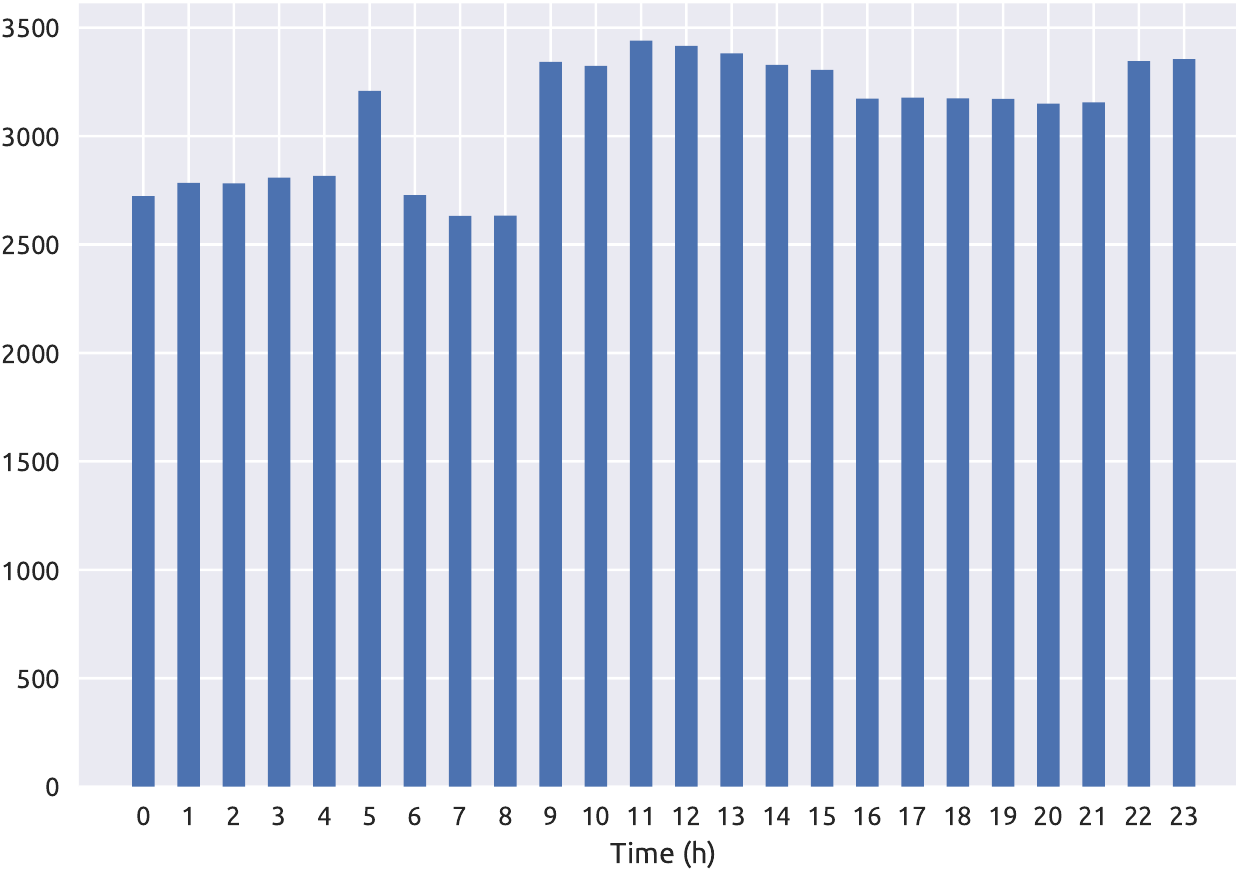
Figure 2. NET3 water distribution network total hydraulic demands over a 24 h